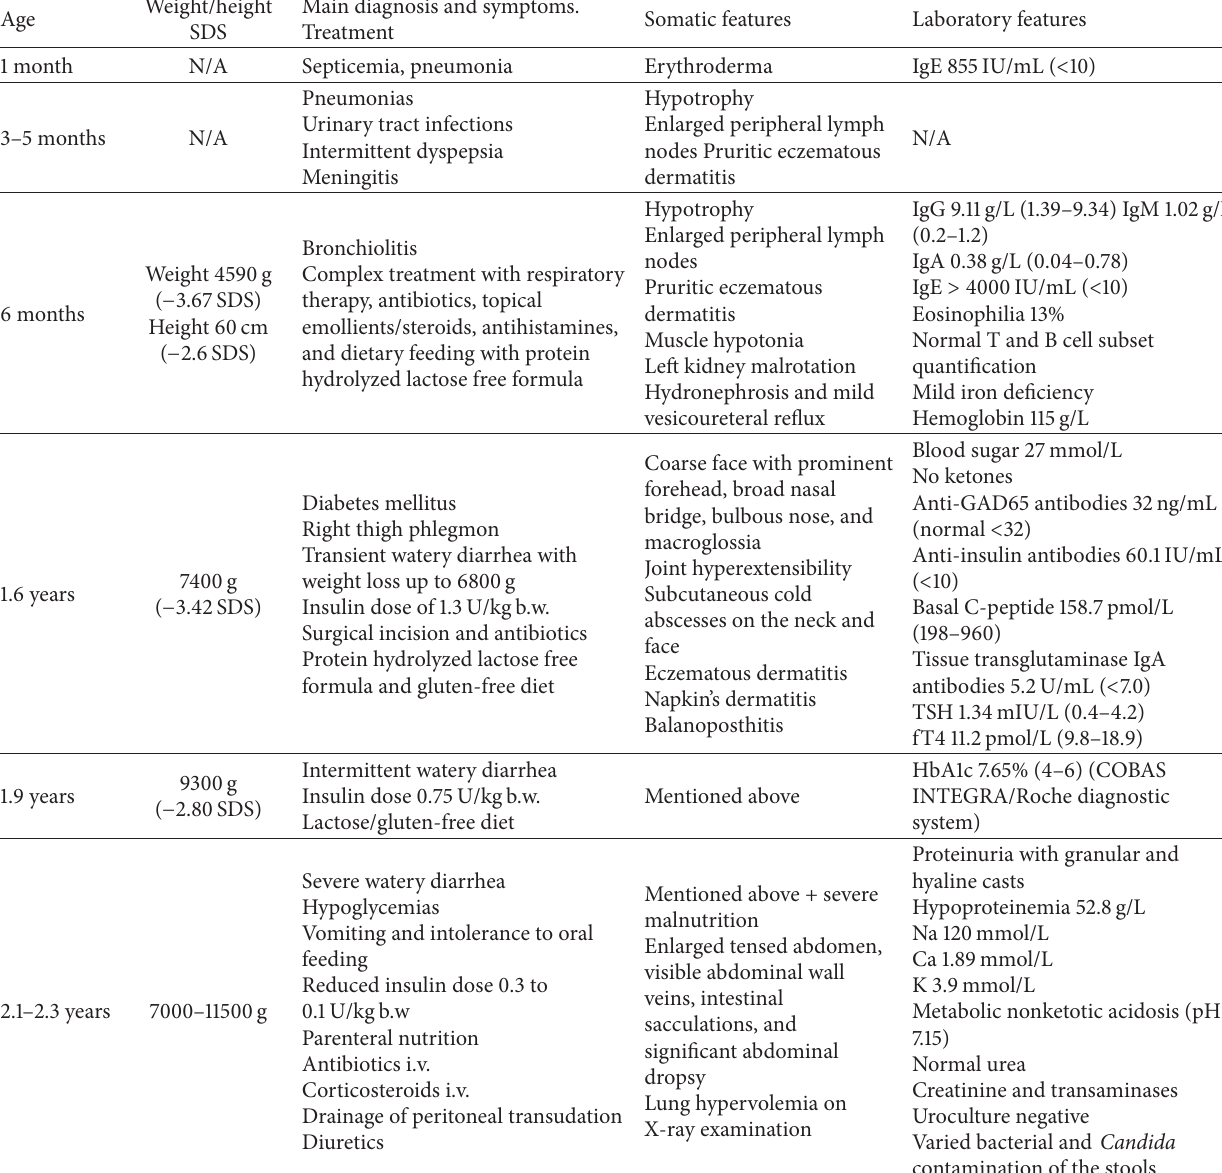
Table 1: Disease history with main symptoms, somatic features, and laboratory